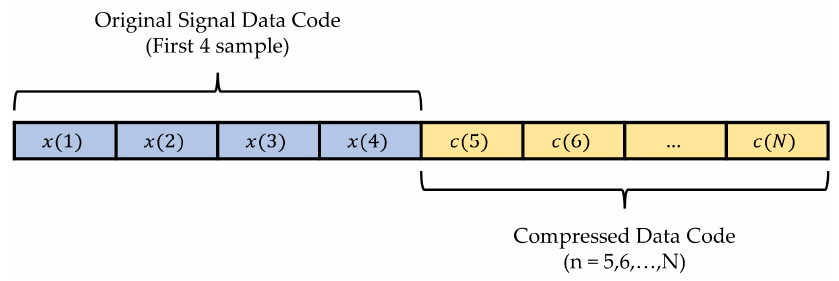
Figure 6. Data package of the compressed data.